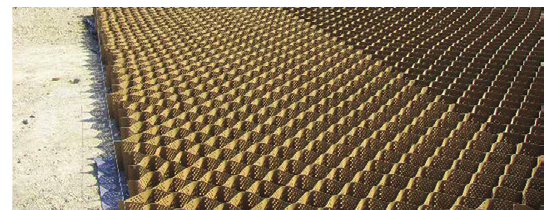
Figure 4. Application of cellular confinement